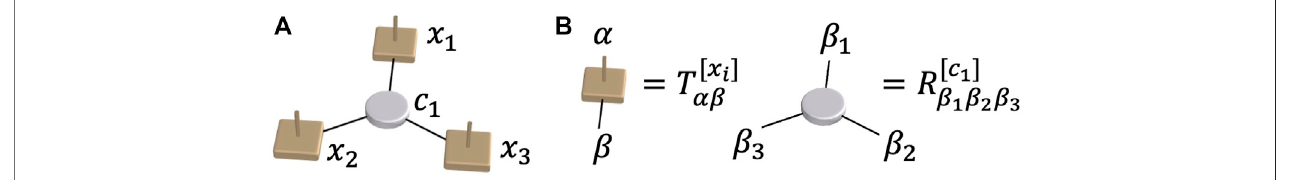
FIGURE1| Tensornetworkconstructionforathree-variableconstrainedproblem. (A) Theschematicforthethree-variableconstrainedproblemwith x 1 , x 2 , x 3 ∈ {0, 1} andtheconstraint c 1 . (B) Thetensorde fi nitionsinthegeneralformofthetensornetworkforthethree-variableconstrainedproblem,with α asthephysicalindexand β as the virtual